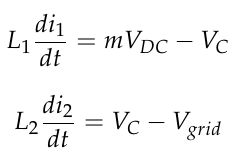
Figure 2. Single-phase VSI with the LCL filter. The equations that describe the system dynamics are shown in (15) and